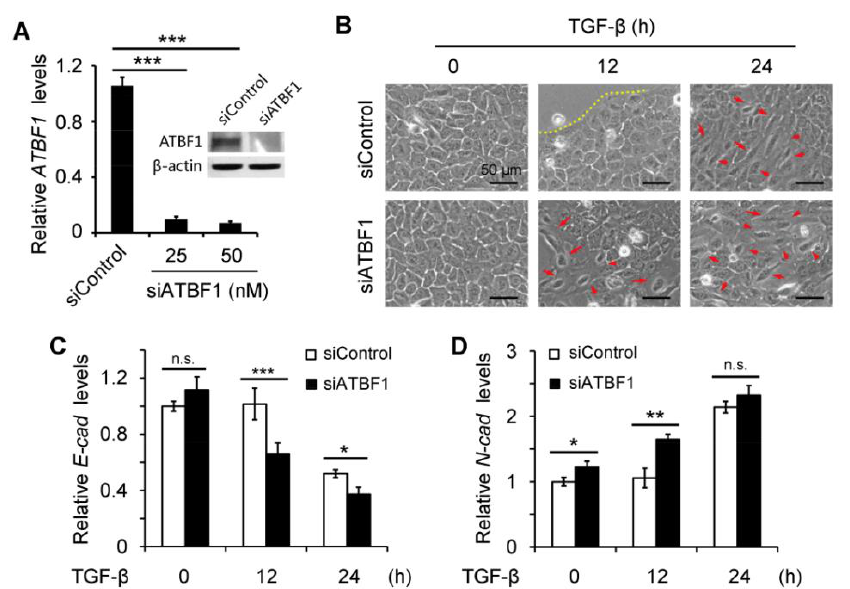
Figure 2. Knockdown of ATBF1 by small interfering RNA (siRNA) promoted EMT progression induced by TGF- β . The efficiency of ATBF1 siRNA was measured by real-time PCR at the concentrations of 25 nM and 50 nM and by western blot at the concentration of 25 nM ( A ). the morphology of cells with or without TGF- β (10 ng / mL) treatment was imaged under a phase contrast microscope ( B ). More mesenchymal-like cells were observed in siATBF1 group after TGF- β treatment for 12 h and 24 h, compared with siControl group ( B ). The expression of E-cad ( C ) and N-cad ( D ) was measured by real-time PCR. * p < 0.05; ** p < 0.01; *** p < 0.001; n.s., no significance. Triplicates were performed for each group.